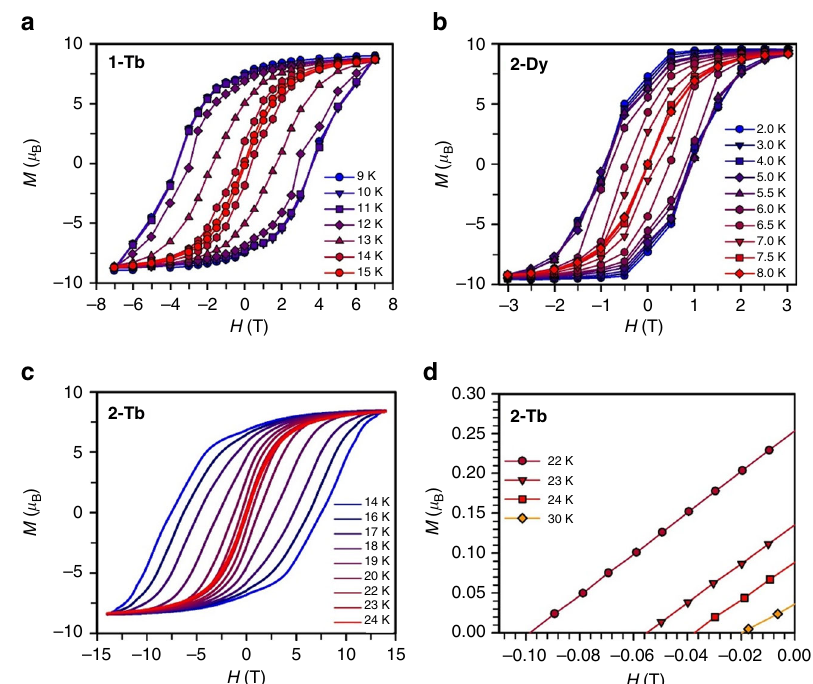
Fig. 5 Magnetic hysteresis data for radical complexes. Plot of magnetization ( M ) vs. dc magnetic fi eld ( H ) at an average sweep rate of 0.01 T/s for a 1-Tb from 9 to 15 K, b 2-Dy from 2 to 8 K, c 2-Tb from 14 to 24 K, d 2-Tb from 22 to 30 K. The magnetic hysteresis loops are effectively closed at 15 K for 1-Tb , 7.5 K for 2-Dy , and 30 K for 2-Tb , and are open for lower temperatures. For 2-Tb , the coercive fi elds observed at 22, 23, and 24 K are ~0.1, 0.06, and 0.04 T,